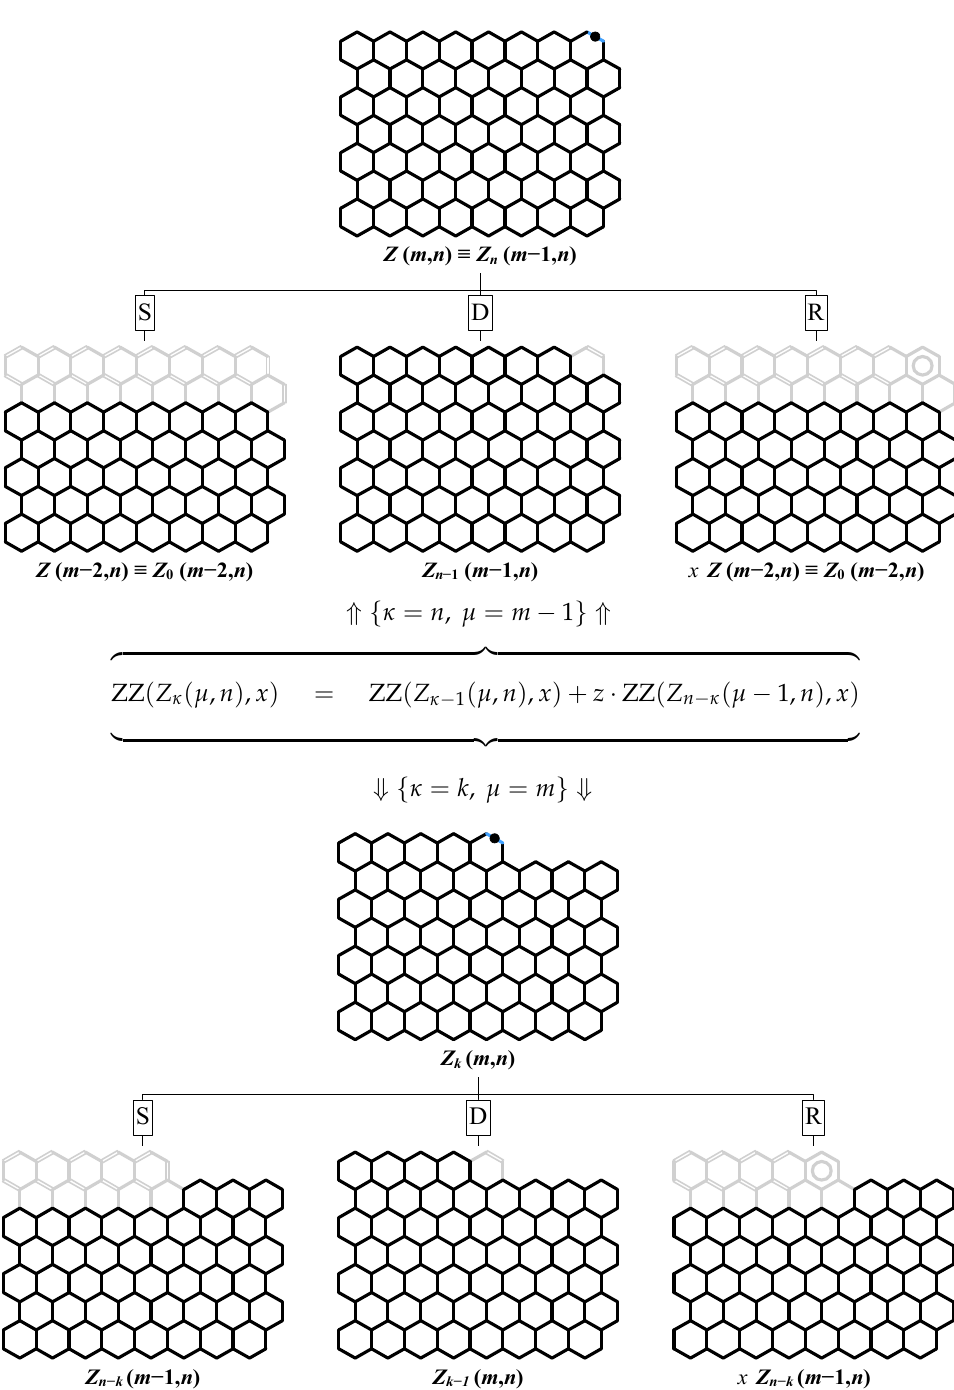
Figure 5. Recursive decomposition of the benzenoids Z ( m , n ) ( upper panel ) and Z k ( m , n ) ( lower panel ) with respect to the edge depicted in blue and marked with a black dot produces in each case three benzenoids isostructural to Z ( m , n ) or Z k ( m , n ) . Both decompositions can be represented by the same recurrence relation with z = 1 + x , κ = n , and µ = m − 1 for the upper decomposition and κ = k and µ = m for the upper